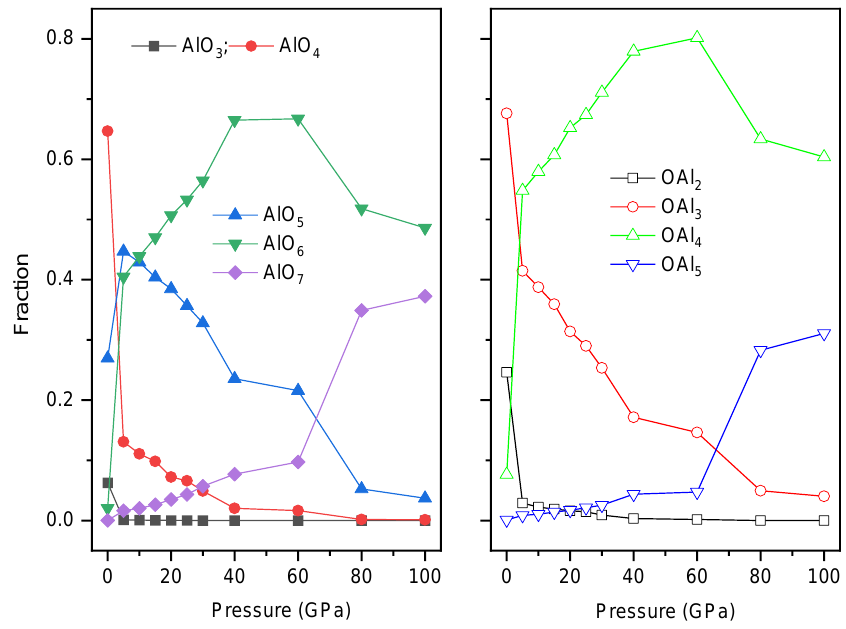
Figure 2. Dependence of coordination number distribution on applied pressure for: AlO x (left) and OAl y